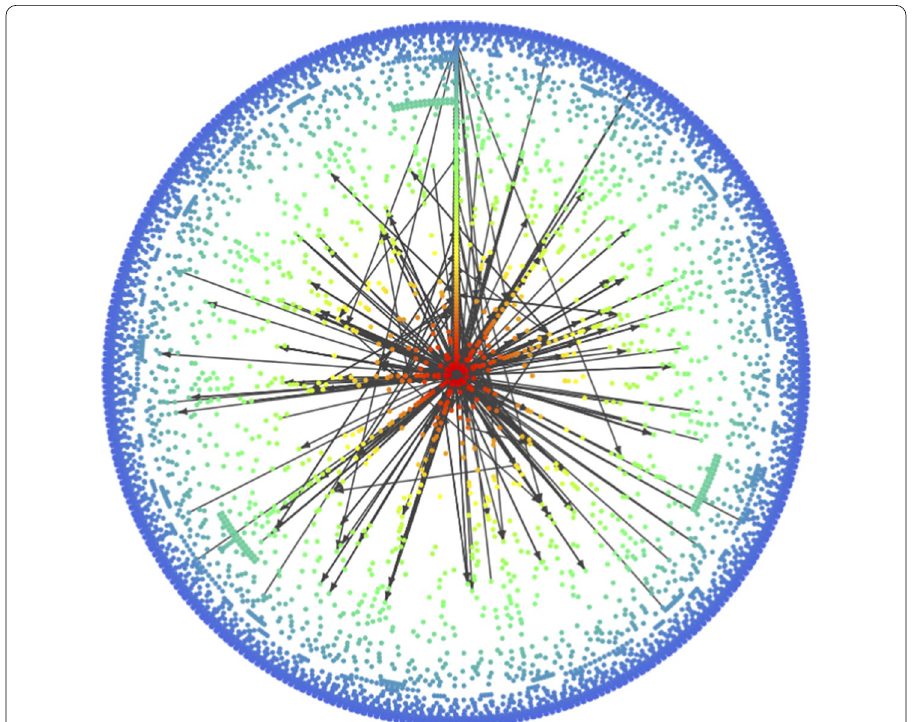
Fig. 7 Core decomposition of the I nstancEs network, based on node in-degrees. Nodes having the same core-index are assigned the same color (inner-most, resp. outer-most core correspond to red, resp. blue). To avoid cluttering, only edges having a weight greater than the first quartile of (unique) edge weights are displayed